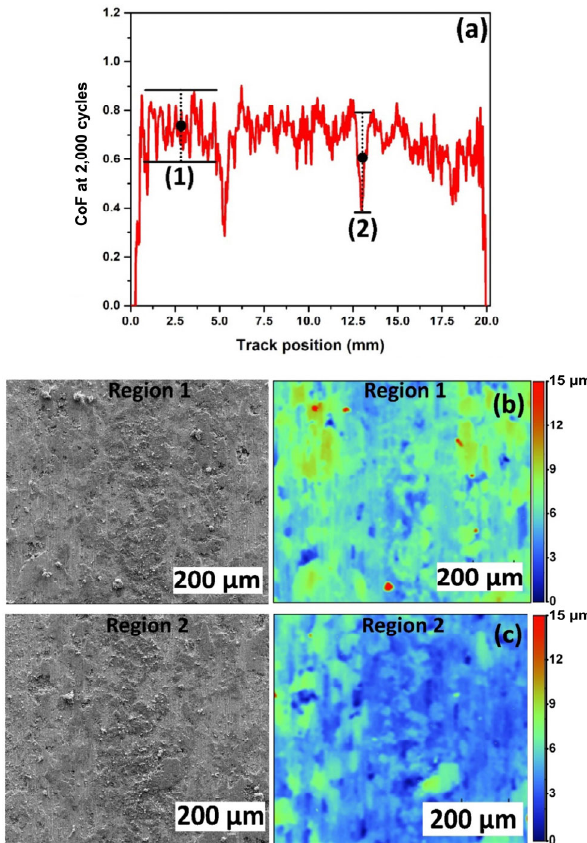
Fig. 15 (a) CoF with track position at end of test (2,000 cycles) showing: (b) elevated Fe substrate and (c) Cd coating present at the contact interface.